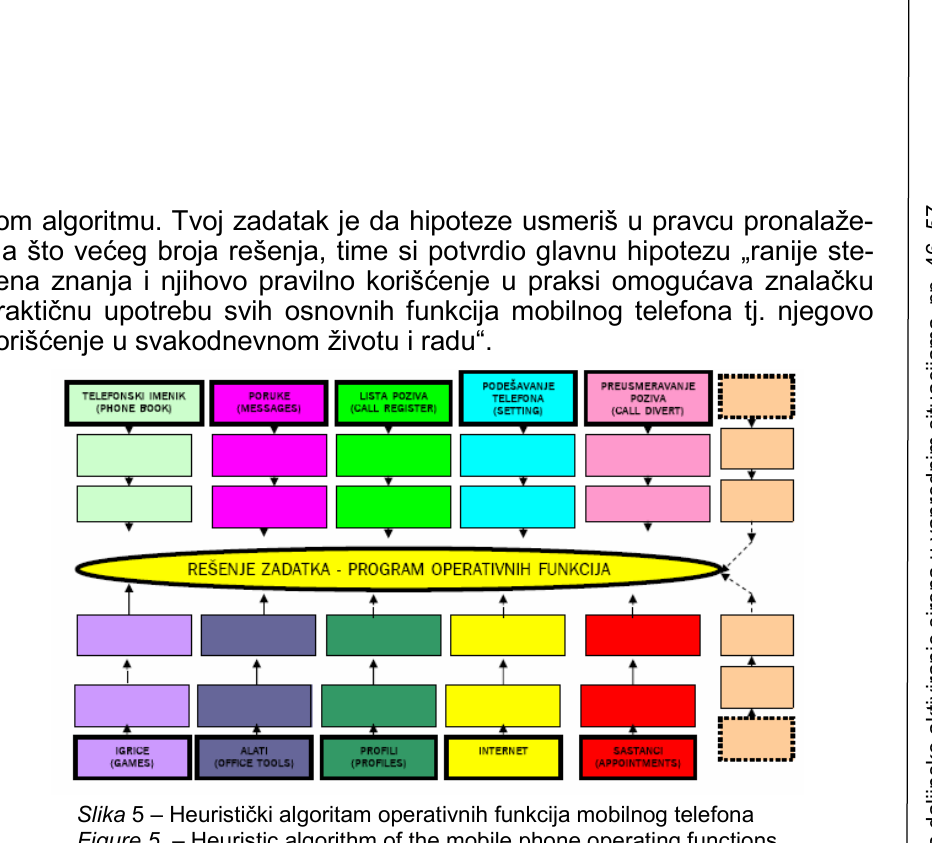
Figure 5 – Heuristic algorithm of the mobile phone operating